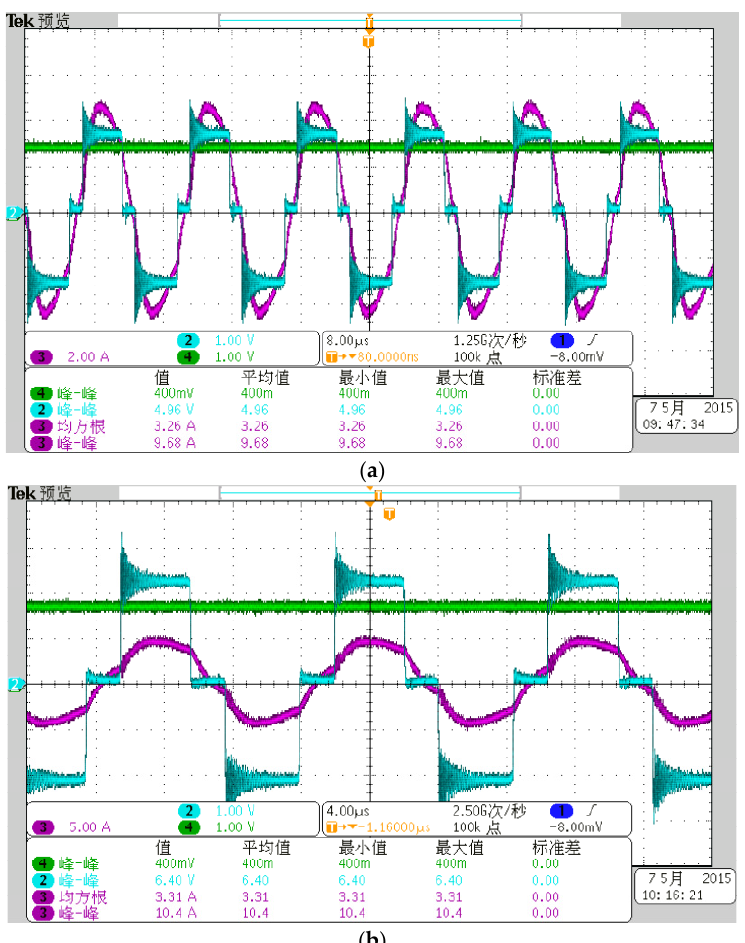
Figure 17. Purple curve: the currents produced by the H Bridge; cyan curve: the output voltages produced by the H Bridge; green curve: the capacitor voltages of the q ‐ Zsource measured ( a ) at the 1 μ s shoot ‐ through time; and ( b ) at the 1.5 μ s shoot ‐ through time. Figure 18a indicates that the charging power or current can be adjusted by changing the shoot ‐ through times. Take the 200 V input voltage as an example, the charging current is 5.26 A when